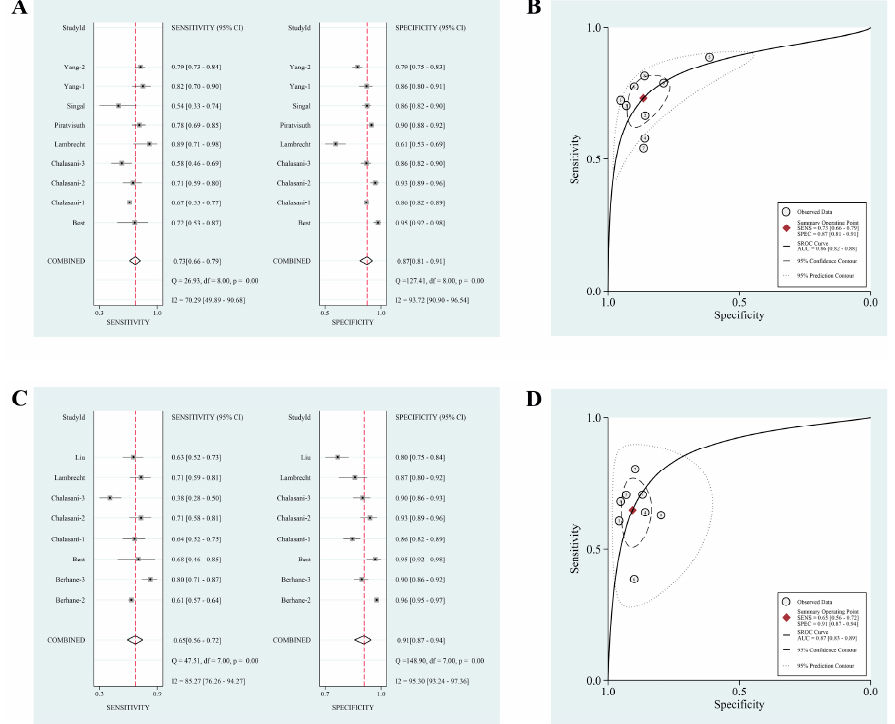
Figure 3. The pooled sensitivity and specificity with Forest plots as well as summary receiver operating characteristic curves of GALAD score for discriminating early-stage hepatocellular carcinoma within Barcelona Clinic Liver Cancer 0/A staging ( A , B ) or within Milan criteria ( C , D ) in chronic liver diseases.